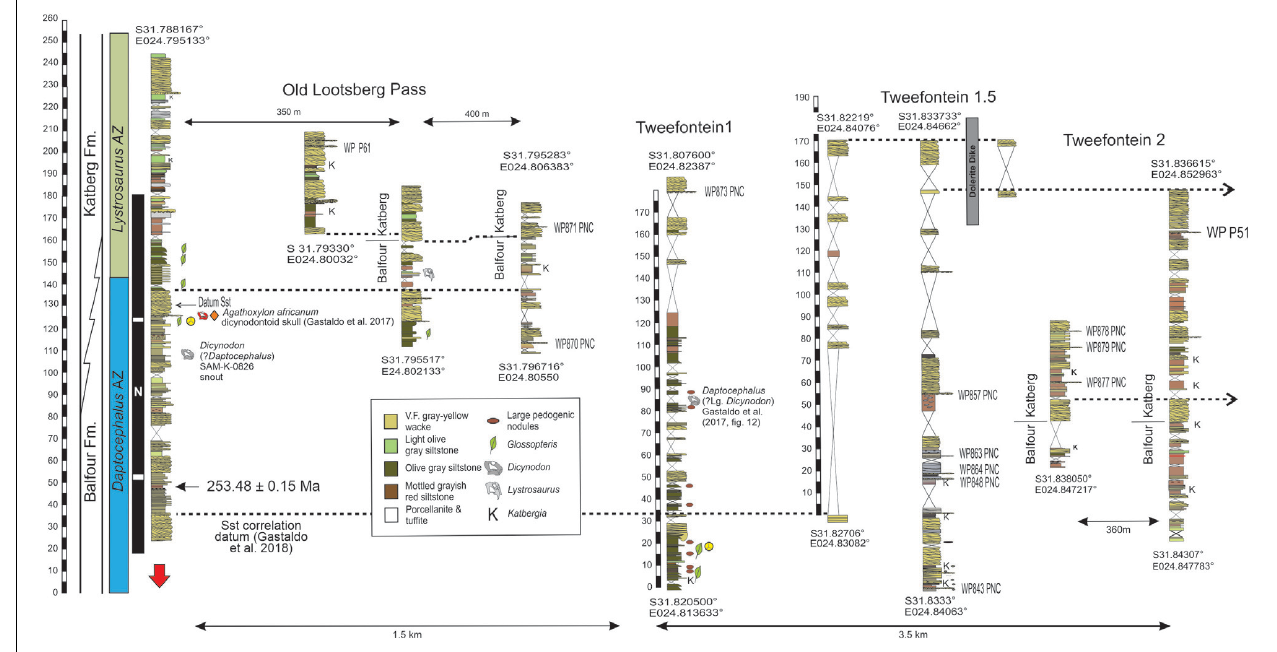
FIGURE 4 | Measured stratigraphic sections correlated using traceable sandstone-channel deposits (dotted lines) in which sampled intraformational pedogenic nodule conglomerate (PNC) are identified with their waypoint (WP) designation. Dotted lines of sandstone datums to the right in the diagram continue to the east around the nose of the escarpment to Lootsberg Pass (measured and correlated sections not shown). GPS coordinates of measured sections are provided, the U-Pb CA ID-TIMS age from a porcellanite as reported by Gastaldo et al. (2018) is placed in magnetostratigraphic context, and selected vertebrates of the Daptocephalus Assemblage Zone (blue vertical bar) noted in the Old Lootsberg Pass and Tweefontein 1 sections (see Gastaldo et al., 2017). The boundary between the Daptocephalus and Lystrosaurus (light green) AZs follows our previously published placement (Gastaldo et al., 2017, 2018). If the definition for the base of the Katberg Formation advanced by Johnson (1976) is applied to individual sections–the horizon above which there is a marked increase in sandstone abundance–this boundary plots at multiple horizons. Thus, the Balfour—Katberg formation boundary is shown as a transition zone (Johnson, 1976; Groenewald, 1996). Vertical scale in 5 m